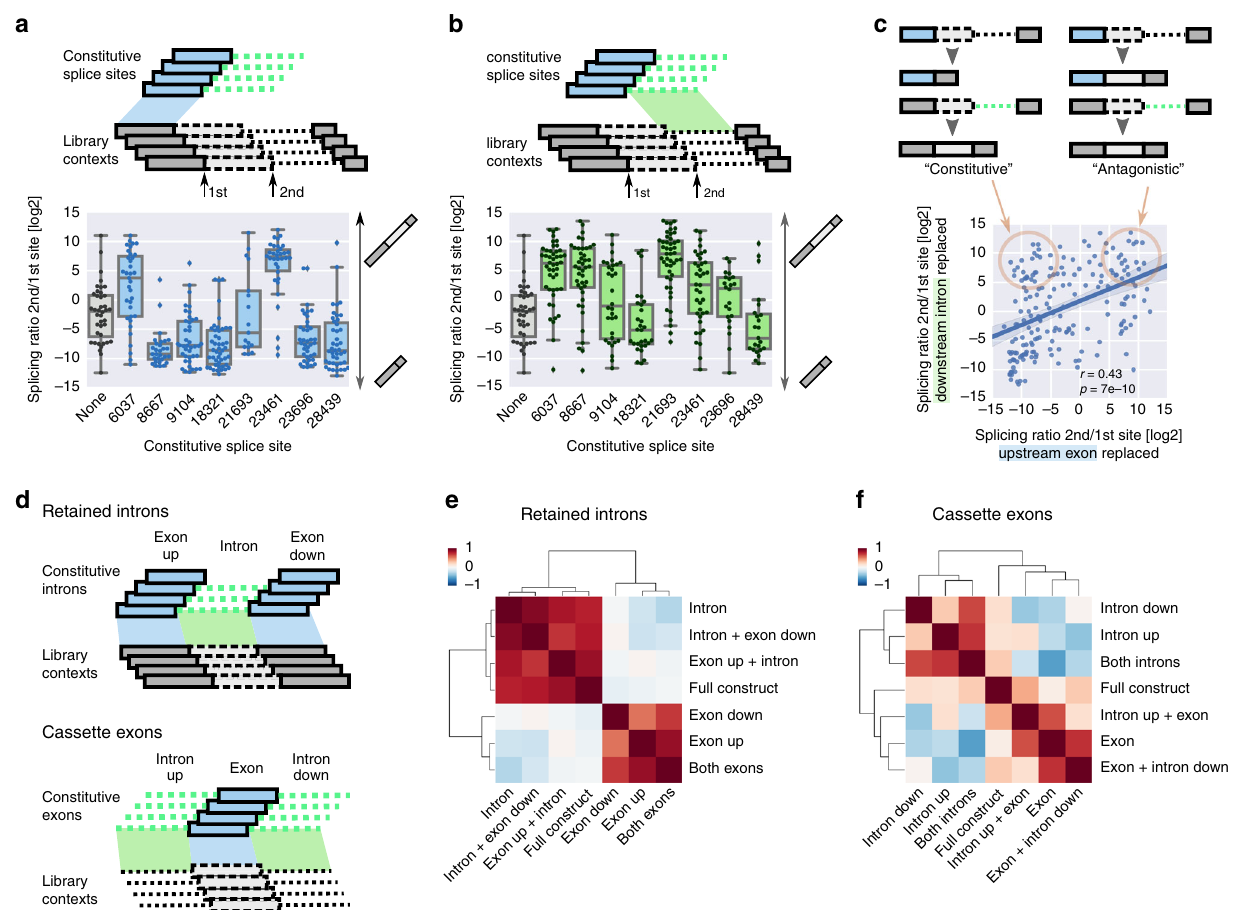
Fig. 3 Antagonistic interactions between building blocks shape the overall splicing outcome. a , b Distribution of splicing ratios (2nd/1st) in tandem 5 ′ splice sites in variants with the upstream exon ( a , blue) or the downstream intron ( b , green) replaced with the corresponding exonic or intronic part from a set of eight constitutive 5 ′ splice sites ( n = 17 – 47 in each group); gray box plots and data points denote wild-type splicing ratios; boxes show the quartiles of the dataset, whiskers show the range of the distribution not including outliers (displayed as points). c . Each data point represents the log ratio (2nd/1st splice site) for a pair of exonic (blue, x -axis) and intronic (green, y -axes) from the same native constitutive donor site placed in a library context ( n = 279; based on the same data as the box plots in a , b ). The schematic on top illustrates the expected behavior in the case of “ constitutive ” splicing behavior triggered by the introduced component (left) or antagonistic (right, in the example shown: an intronic component (green) promotes usage of the 2nd (the adjacent) splice site and an exonic component (blue) from the same native donor site is not able to trigger usage of the fi rst (the adjacent) splice site, both leading to high splicing ratios (2nd/1st)). Pearson correlation coef fi cient and the associated p -value are stated. d Schematic for the replacement of components of the retained intron (top) and cassette exon (bottom) library contexts with elements from a set of “ constitutive ” splice site sequences (with no evidence in RNAseq data for retention of the intron or skipping of the exon, respectively. e , f Clustered heatmaps showing Pearson correlation coef fi cients for all pairwise combinations of effects on splicing ratio in ( e ) retained introns or ( f ) cassette exons conveyed by the indicated elements across contexts ( n = 96 – 215 and 48 – 143 for each